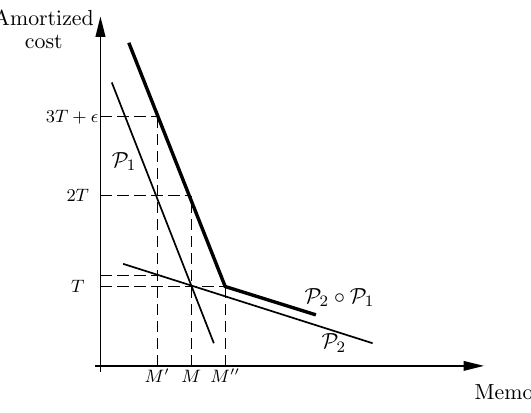
Fig. 5. Time-memory tradeoff for the composition of hard problems with different